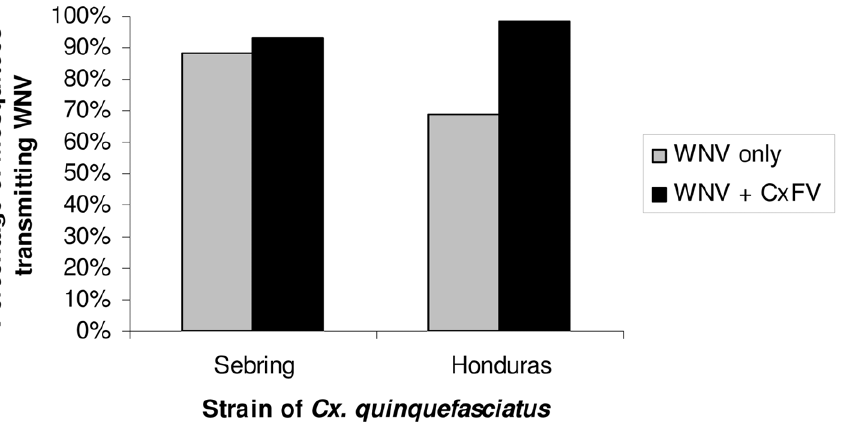
Figure 6. WNV transmission by CxFV Izabal ( + ) and CxFV Izabal (-) mosquito colonies. Percentage of Cx. quinquefasciatus transmitting WNV nine days following intrathoracic inoculation with either WNV alone or WNV + CxFV Izabal. For the Honduras colony, a significantly higher percentage of mosquitoes inoculated simultaneously with both viruses transmitted WNV than mosquitoes that were inoculated with WNV alone (Fisher’s exact test, p=0.0014).